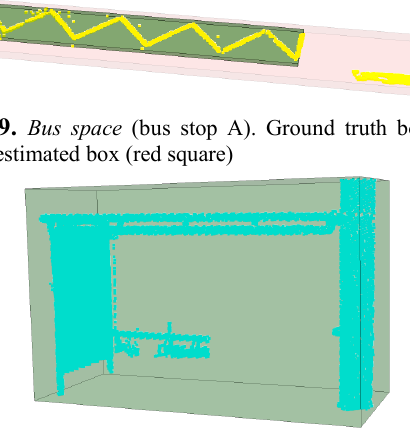
Figure 10. Pedestrian space (bus stop B). The estimated box is coincident with the ground truth.